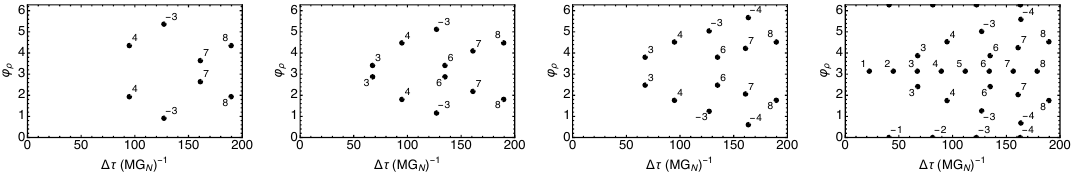
Figure 5 . Possible echos generated by bright point-like spots that are located in the photon shell of a black hole that is pierced by a cosmic string. The plots are given for a cosmic string that coincides with the black hole spin axis and has an orientation that corresponds to the + sign in (4.14). In these plots the black hole spin parameter a is fixed to be a ( MG N ) − 1 = 0 . 7 and the observer inclination θ o varies. From left to right: θ o = 30 ◦ , θ o = 50 ◦ , θ o = 70 ◦ , θ o = 90 ◦ . The angular location ϕ ρ of the echos on the screen of an observer is plotted against the time interval ∆ τ after which the echos appear. The labels of the dots are the generated phases ∆Φ (2 πC ) − 1 that rotate the polarization direction of linear polarized photons of that particular echo. These are all integer numbers because the echos come from photons of the same point-like source that circle the black hole on closed orbits which implies that ∆ ϕ is an integer-multiple of 2 π (see (4.13),